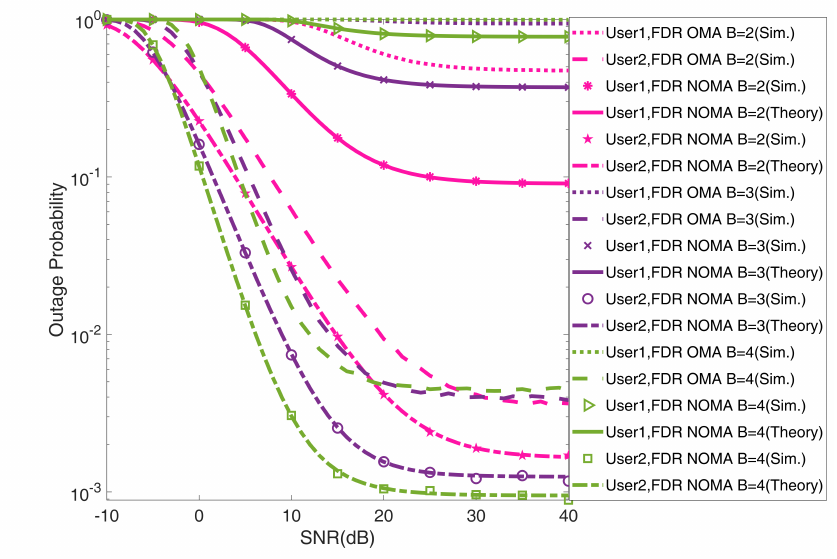
Figure 7. Outage probability of U 1 and U 2 versus SNR for UAV-FDR based-NOMA and OMA schemes ( E ( | h LI | 2 ) = − 15 dB